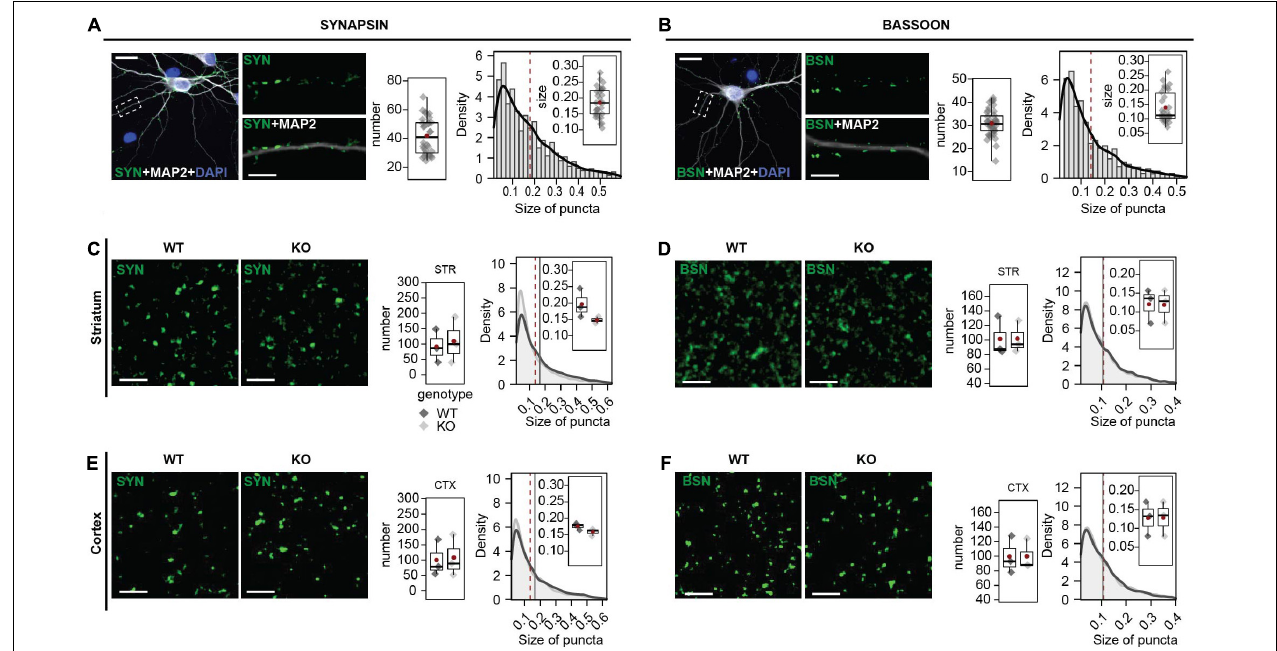
FIGURE 3 | SYNAPSIN1/2 and BASSOON expression in primary hippocampal neurons, mouse striatum, and cortex. (A) SYNAPSIN1/2 and MAP2 ICC in primary hippocampal neurons. The number of SYNAPSIN1/2 positive synapses per 30 µ m secondary dendrite and the size of the puncta were analyzed. (B) BASSOON and MAP2 ICC in primary hippocampal neurons. The number of BASSOON-positive synapses per 30 µ m secondary dendrite and the size of the puncta were analyzed. Scale bar 20 µ m. (C) SYNAPSIN1/2 IHC in striatum of WT and Shank3 KO mice. The number of SYNAPSIN1/2-positive synapses per 17 µ m 2 and the size of the puncta were analyzed. Scale bar 20 µ m. (D) BASSOON IHC in striatum of WT and Shank3 KO mice. The number of BASSOON-positive synapses per 17 µ m 2 and the size of the puncta were analyzed. (E) SYNAPSIN1/2 IHC cortex of WT and Shank3 KO mice. The number of SYNAPSIN1/2-positive synapses per 17 µ m 2 and the size of the puncta were analyzed. (F) BASSOON IHC in cortex of WT and Shank3 KO mice. The number of BASSOON-positive synapses per 17 µ m 2 and the size of the puncta were analyzed. Scale bar 5 µ m. Left graph: Number of synapses. Right graph: Size of SYNAPSIN1/2 puncta, frequency distribution (bins) and estimated density (black line). The boxplot shows the median and the interquartile range, the whiskers cover minimal-to-maximal values. The red dot or the red line mark the mean. ICC: Data collected from a total of 40 cells of 4 independent experiments. IHC: n = 3 mice per genotype. WT: Shank3( + / +), KO: Shank3 (cid:49) ex11(–/–) mice. Groups were tested for normality using the Shapiro–Wilk test and then compared using the Wilcoxon